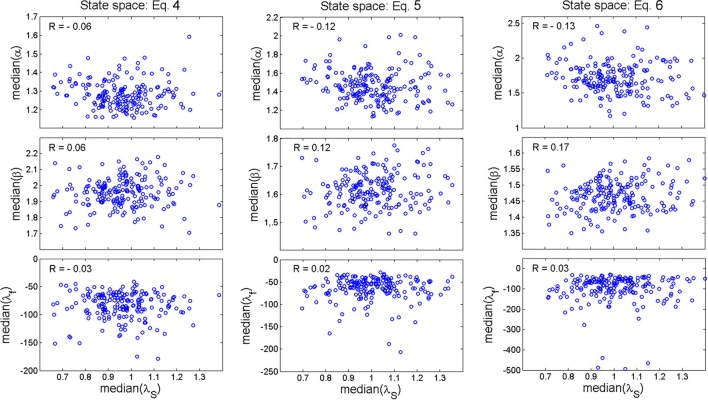
Scatterplot of the relationship between the median values of the fractional stability parameters, α, (upper
row of panels), β (middle
row of panels), λf (lower
row of panels), and the median values of the exponential stability parameter λS for state space reconstruction method of Equation (4) (left
column of panels), Equation (5) (middle
column of panels), and Equation (6) (right
column of panels). The scatterplots are shown with corresponding Pearson correlation coefficients.